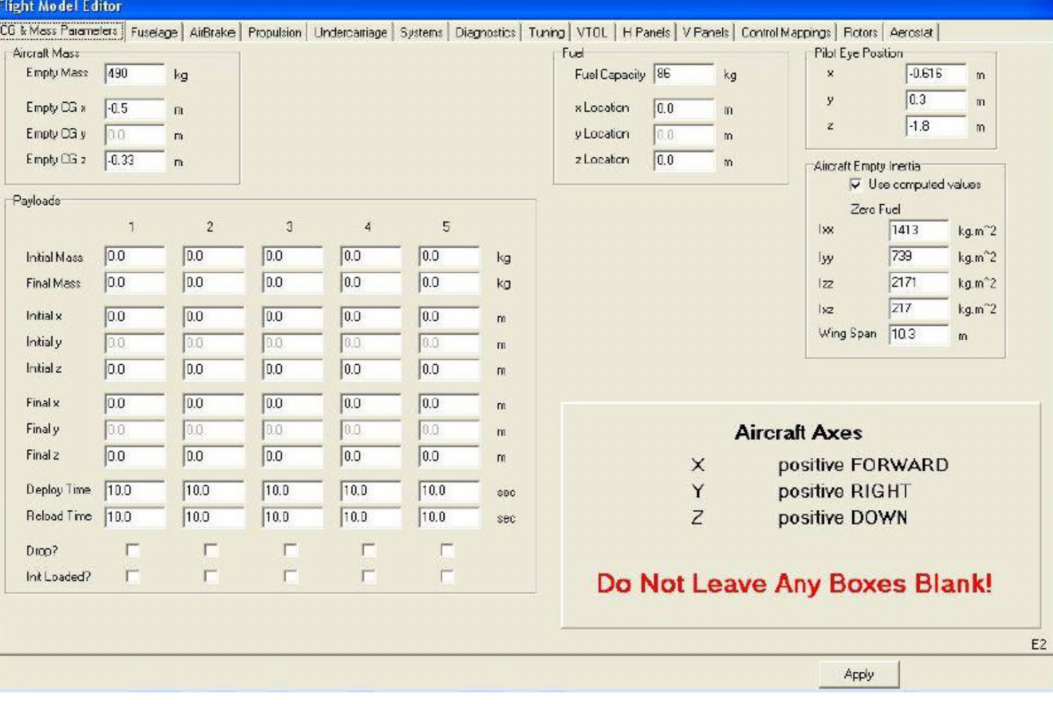
Figure 9. Overview of the flight model editor (CG & Mass Parameters page, from [35], copyright to Merlin Flight Simulation